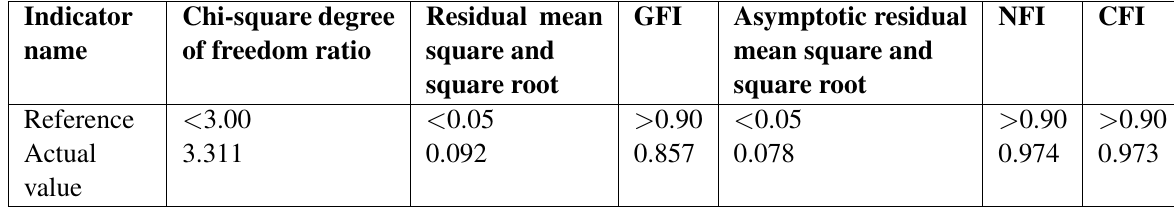
Table 3 Modified model fitness test index